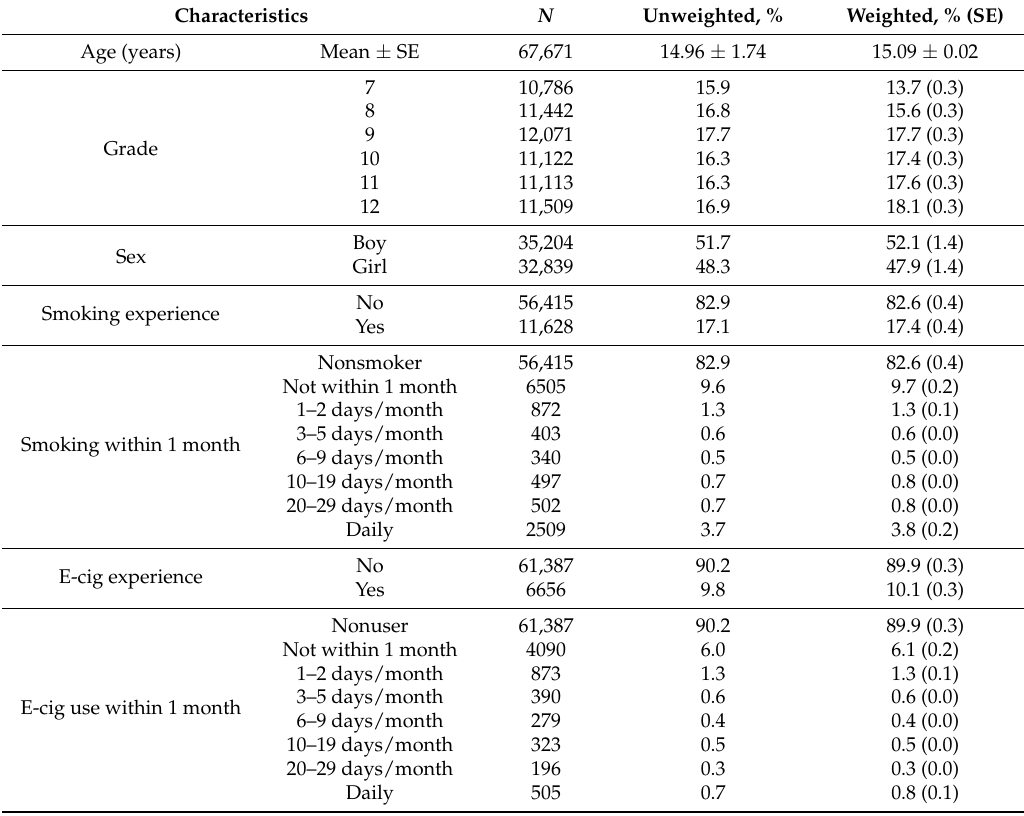
Table 1. Sociodemographic and smoking-related characteristics of participants ( N =